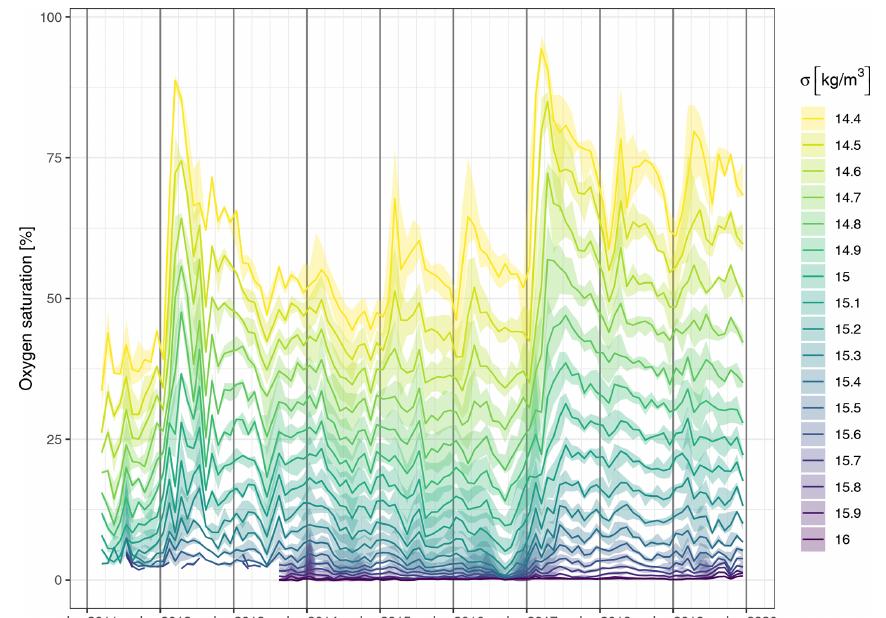
Figure 5. Monthly medians of oxygen saturation at different σ layers. Shaded areas indicate the monthly interquartile range (Fig. 2).